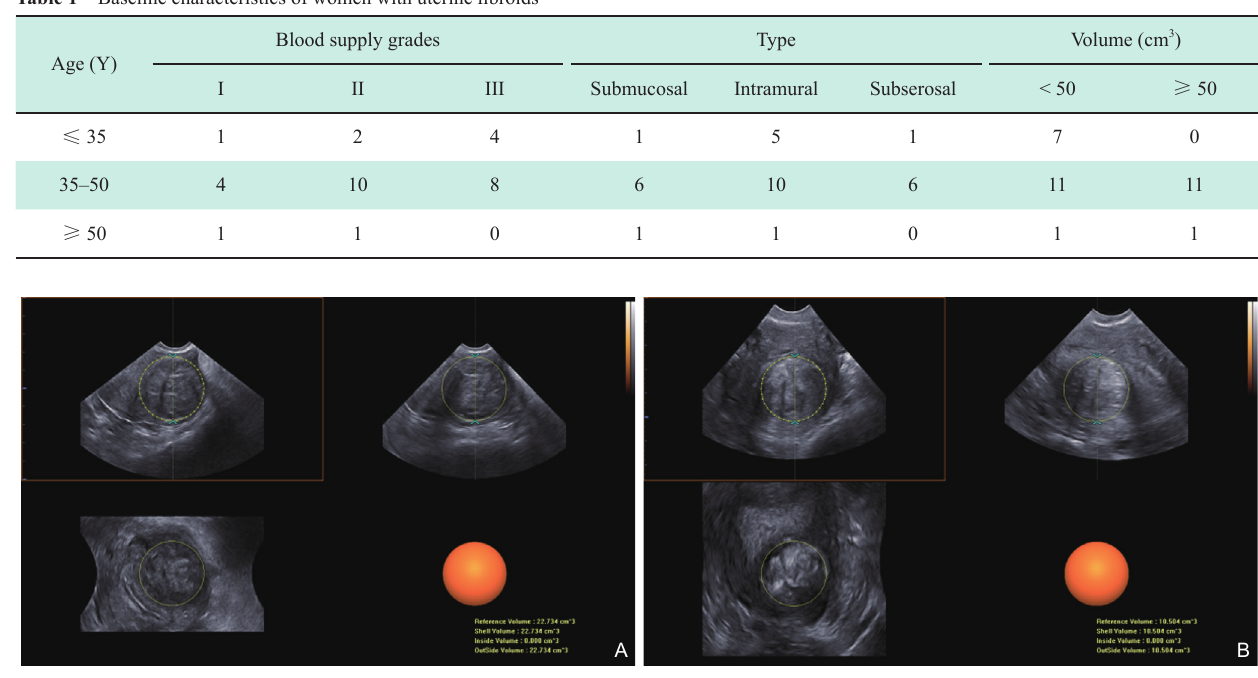
Table 1 Baseline characteristics of women with uterine